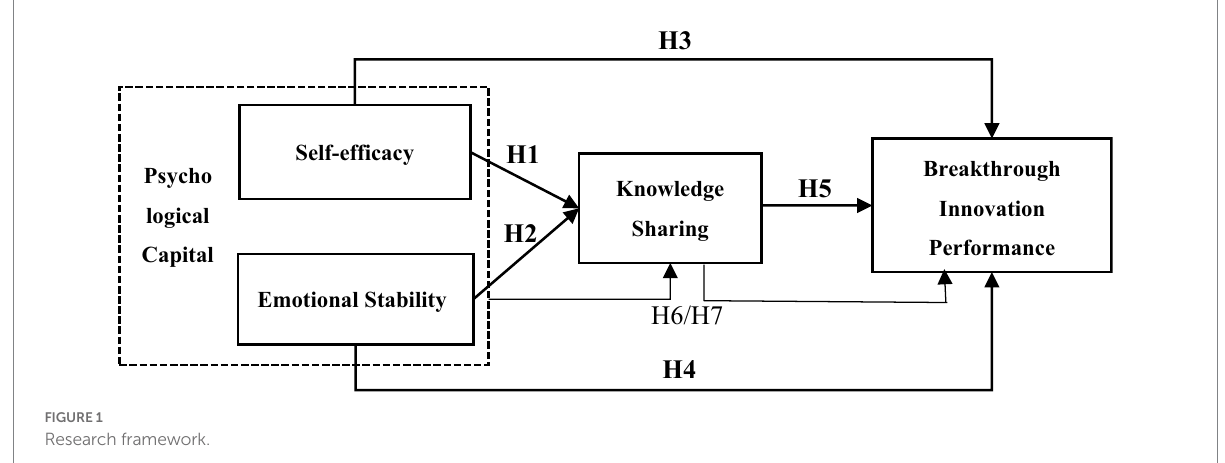
FIGURE 1 Research